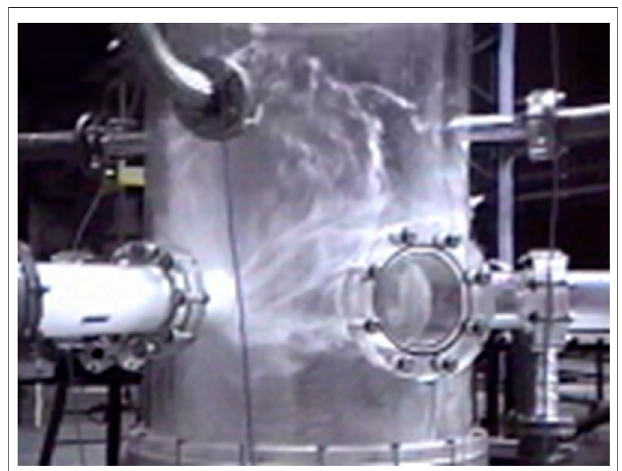
FIGURE 1 | ECC bypass phenomenon in RV downcomer (Cho et al., ( Figure 1 ) If a loss-of-coolant accident occurs with a break in a primary coolant system of the pressurized water reactor, the emergency core coolant (ECC) is injected into the RV downcomer through the direct vessel injection (DVI) nozzle.